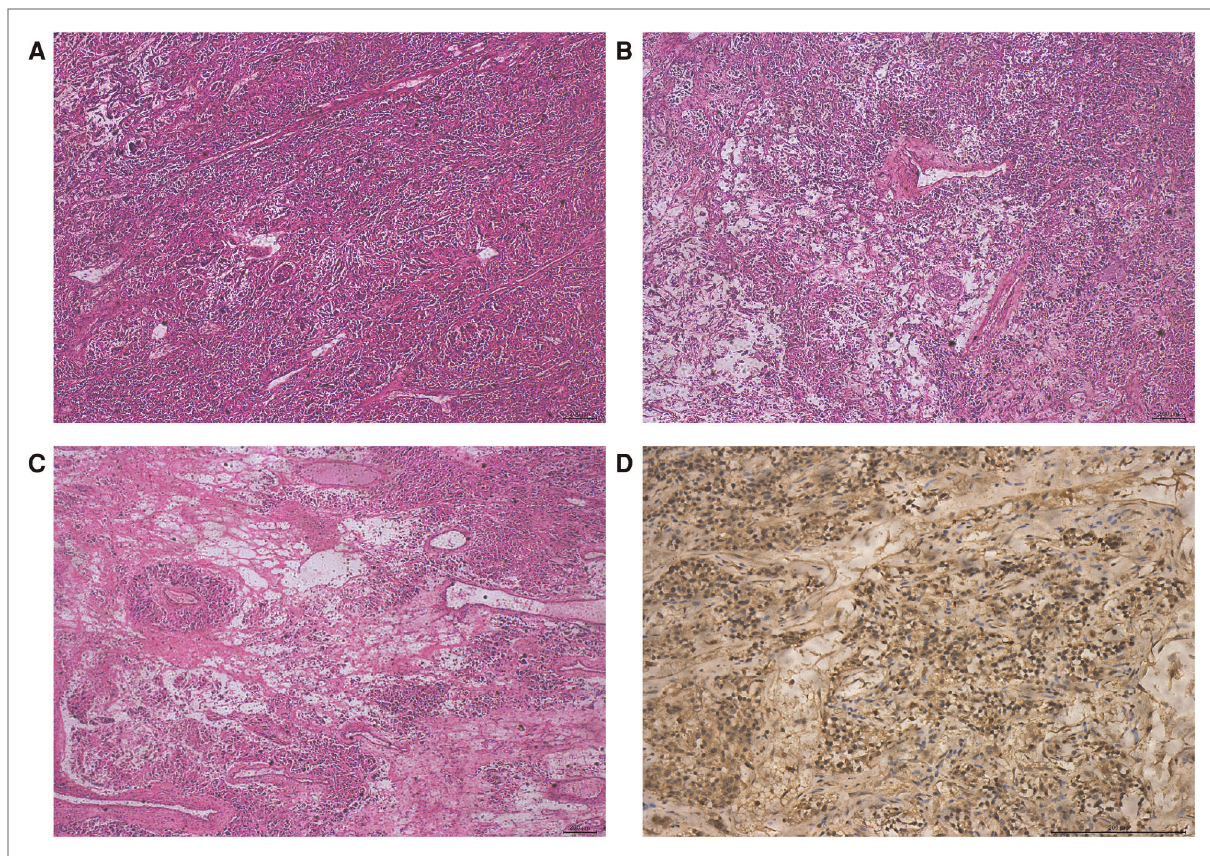
FIGURE 3 Pathological features of malignant AS. HE staining showed that the tumor was mainly in the Antonia area ( A ); transparent vessels and local myxoid degeneration ( B ); adenoid/microcapsule structure ( C ); and immunohistochemical staining showed positive expression of S-100 protein ( D